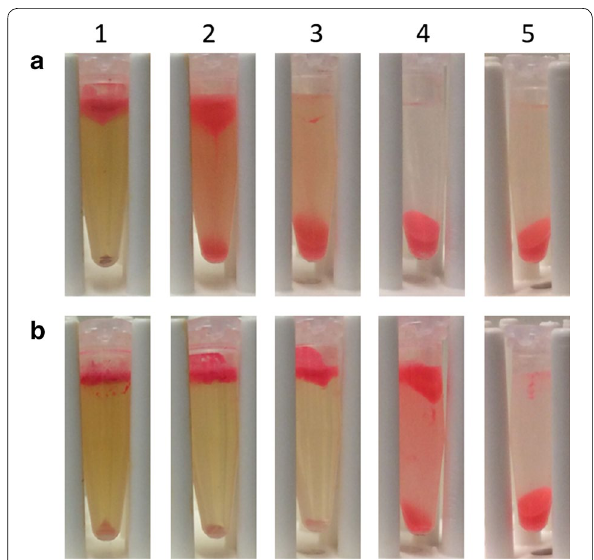
Fig. 5 TME concentration analysis. To test the activity of the tailor-made enzymes (TMEs) a dilution was prepared and incubated for a 4 h or b 24 h. The enzyme concentrations used were column (1) 187 mg L − 1 , column (2) 93.6 mg L − 1 , column (3) 46.8 mg L − 1 , column (4) 18.7 mg L − 1 , and column (5) 9.36 mg L − 1 . The TMEs shown to be active against Schwanniomyces occidentalis at a concentration of 93.6 mg L − 1 with a 4 h incubation time, or at a concentration of 18.7 mg L − 1 with a 24 h incubation time. However, the best results are obtained when using a TME concentration of 187 mg L − 1 and 4 h incubation time, or 46.8 mg L − 1 and 24 h incubation